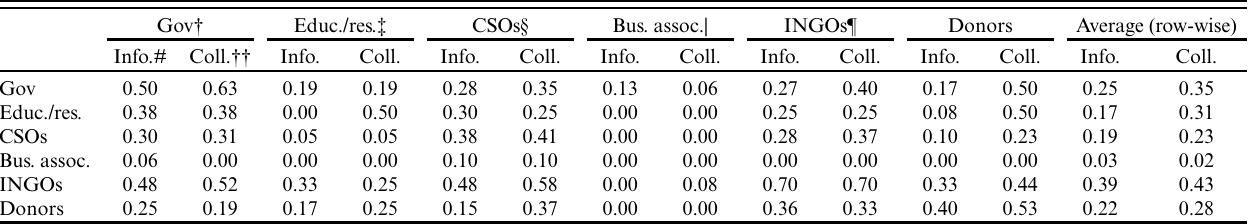
Table 5. Comparison of group-wise density of interaction among and within actor groups for information exchange and collaboration networks in Nepal’s REDD+ policy arena. Scores indicate the density of interactions (as a proportion of all possible ties) among and within actor groups; a score of 0.48 means that 48% of all possible ties are realized. ANOVA test for goodness of fit is significant ( P < 0.05) for government and international nongovernmental